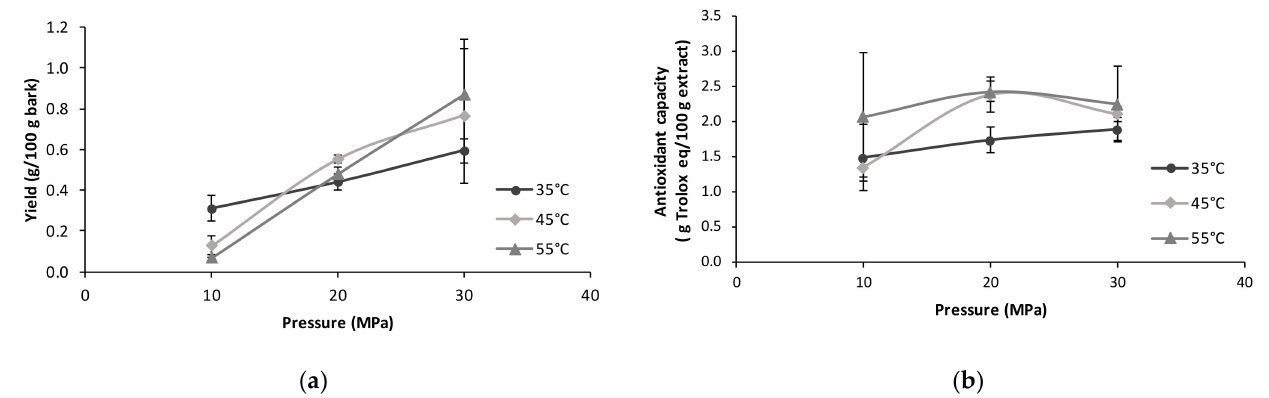
Figure 2. Influence of the extraction pressure and temperature on the extraction yield ( a ), and the antiradical capacity determined as ABTS ( b ) of Paulownia elongata x fortunei bark samples extracted with pure sc-CO 2 for 30 min at the temperatures of 35 ◦ C (dark gray), 45 ◦ C (light gray) and 55 ◦ C (intermediate gray).